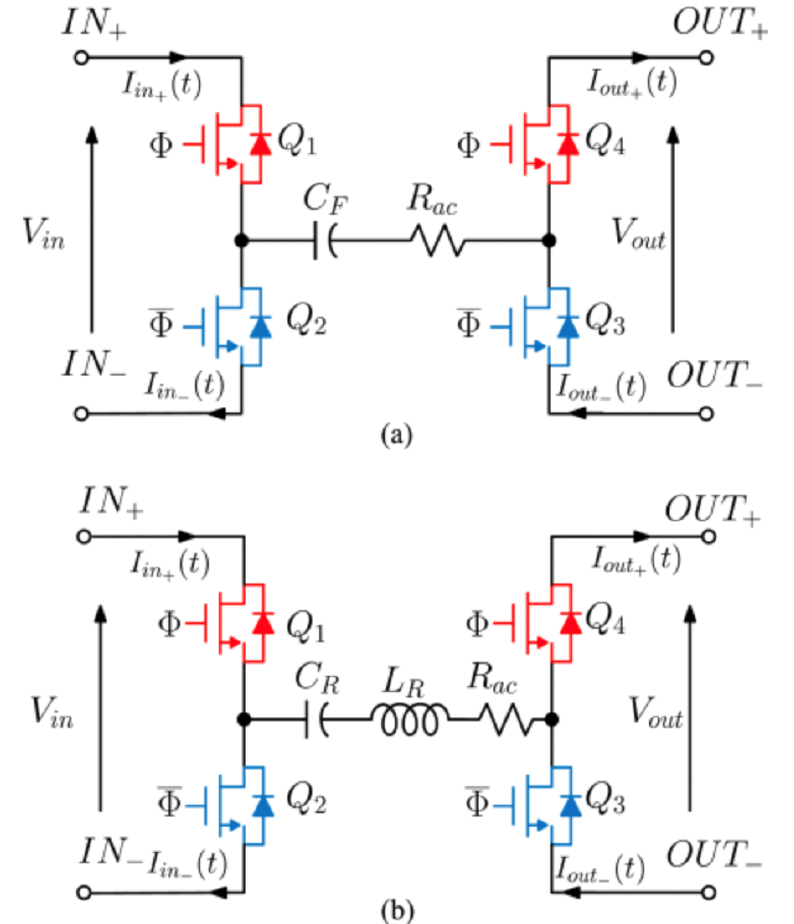
Figure 12. The buiding blocks of the STC presented in [34]: ( a ) structure with a clamping capacitor and ( b ) structure with a LC-resonant